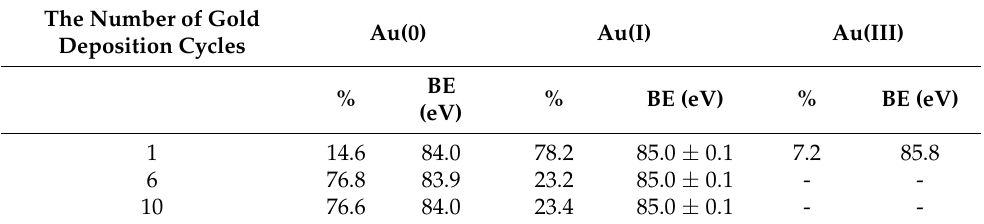
Table 2. Relative concentrations of Au species (%) and binding energies of the Au 4f 7/2 peaks derived from XPS analysis. The Number of